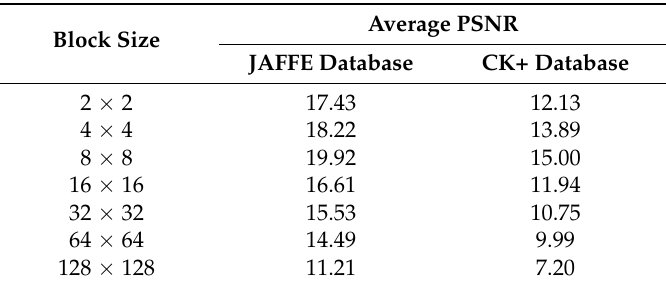
Table 3. PSNR values of different block sizes.